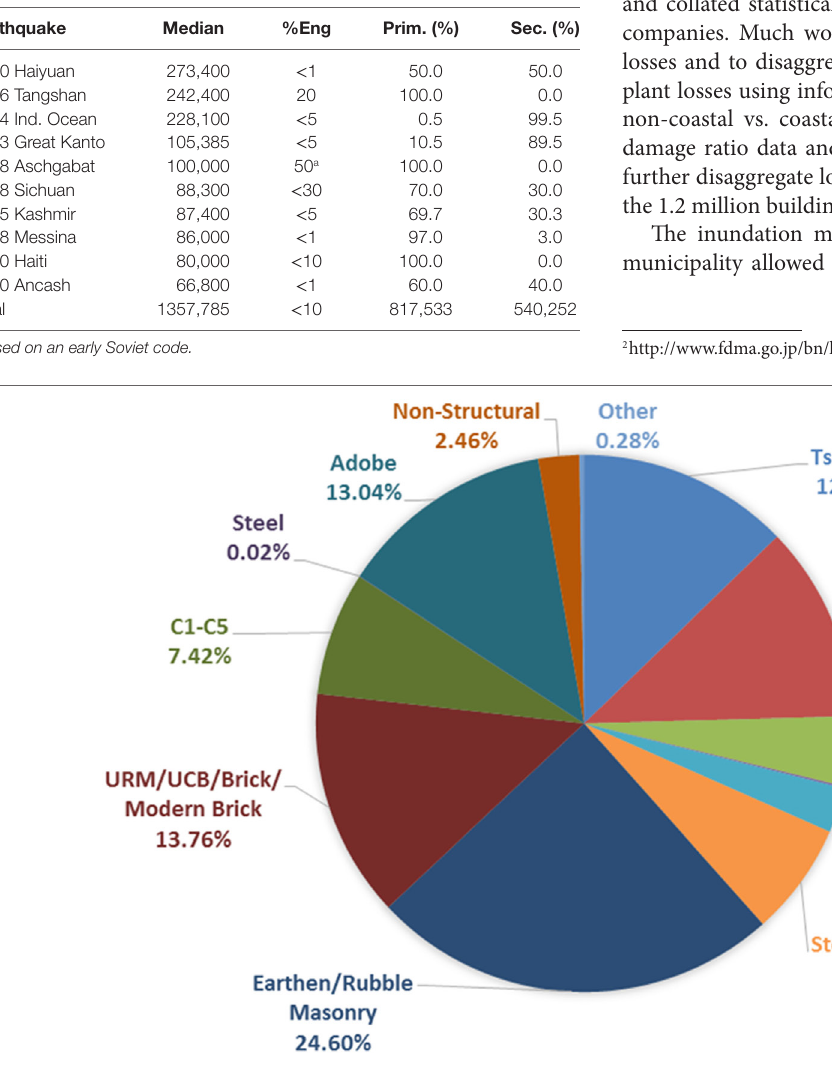
FigUre 6 | The upper and lower bound death toll estimate of earthquakes in global literature compared to the median caTDaT death toll, current as of December 31, 2016